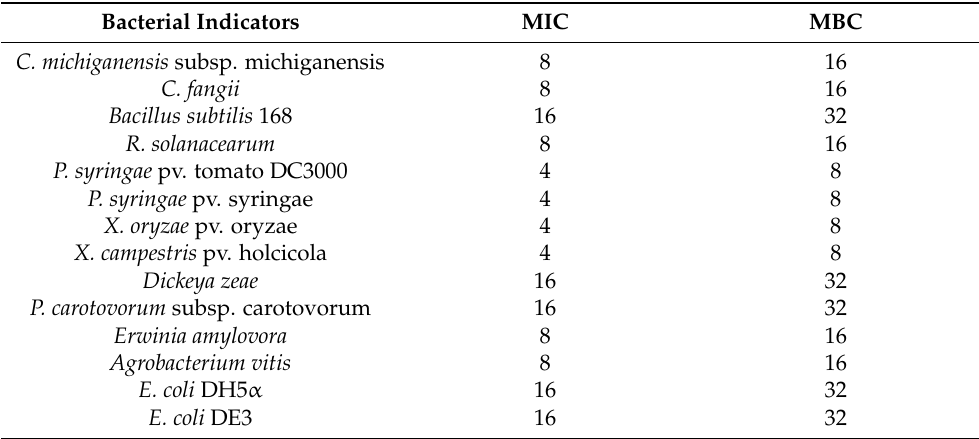
Table 2. Antimicrobial activity assay of the ZM-804 peptide. Minimal inhibitory concentrations (MIC) and minimum bactericidal concentrations (MBC) values ( µ M) against bacterial indicators. Bacterial Indicators